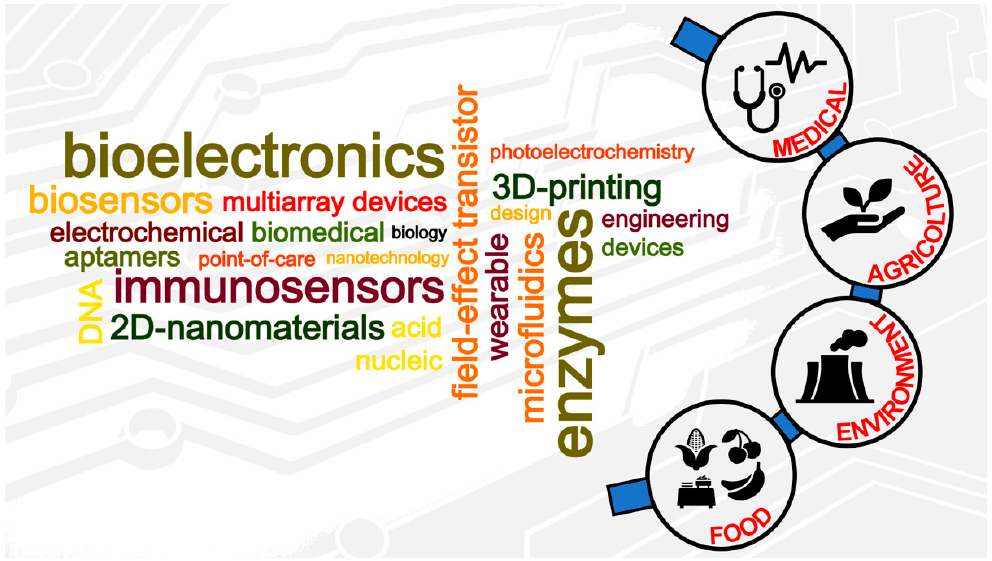
Figure 2. Biosensing topics and sub-topics and possible applications as analytical devices.